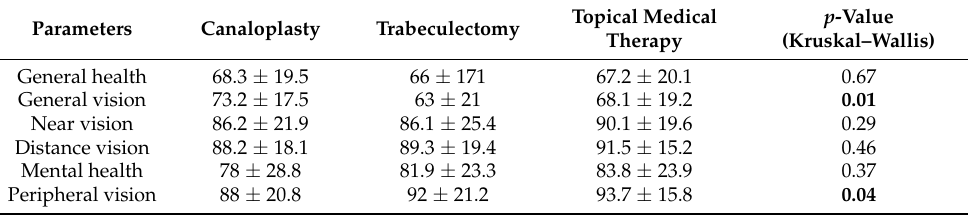
Table 5. General health, general vision, near vision, distance vision, mental health and periph- eral vision parameters of the 25-Item National Eye Institute Visual Functioning Questionnaire (25-NEI-VFQ): comparison between canaloplasty, trabeculectomy and topical medical therapy through the Kruskal–Wallis test.